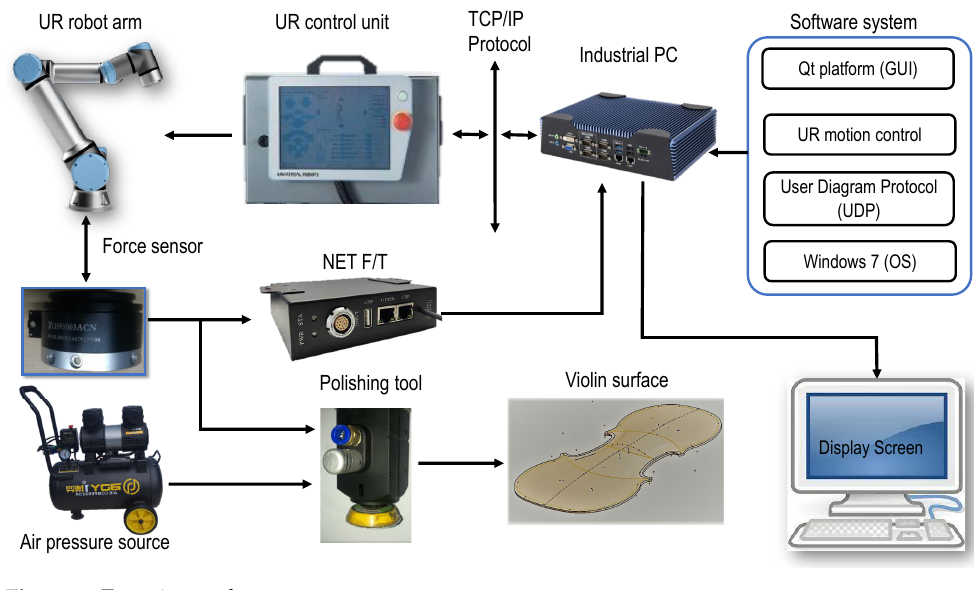
Figure 7. Experimental setup.